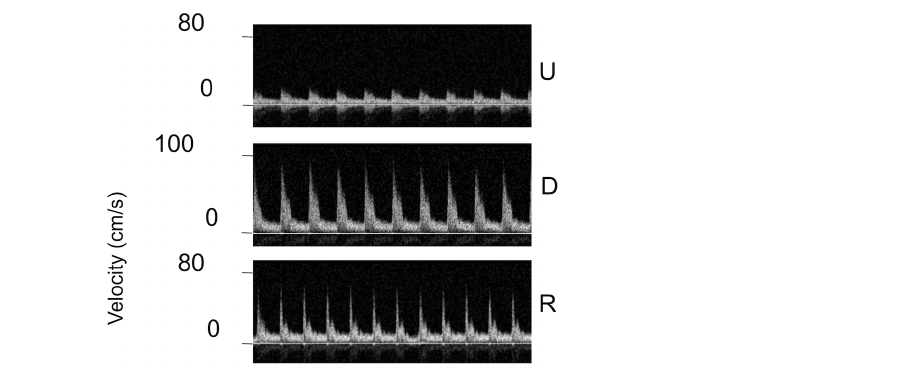
Fig. 4. Measured blood flow velocities. Doppler ultrasound traces showing flow velocity versus time at the upstream (U) and downstream (D) ends of the cuffed left carotid and in the uncuffed right carotid (R) of a mouse with the cuff in the conventional orientation. Note the altered y-axis scale for D.